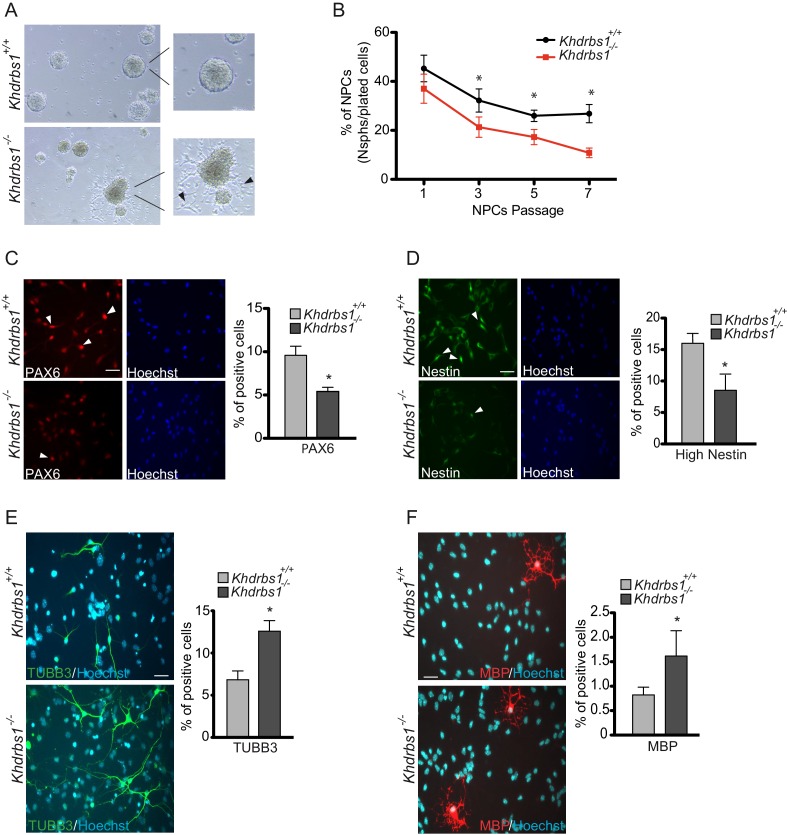
Sam68-/-NPCs lose stemness and are prone to differentiate in culture.(A) Bright field images of Khdrbs1+/+ and Khdrbs1-/- NPCs cultured in proliferating condition for 3 days in culture. The insets show higher magnification of a selected neurosphere. Black arrowheads point to Khdrbs1-/- NPCs exiting the sphere and attaching to the surface. (B) Clonogenic assay of Khdrbs1+/+ and Khdrbs1-/- NPCs. Clonogenicity was expressed as the percentage of neurospheres obtained from the seeded NPCs at each indicated passage. Data represent mean±SD of 3 independent experiments; * p<0.05. (C and D) Immunofluorescence analysis of the stemness markers PAX6 (C) and Nestin (D) in Khdrbs1+/+ andKhdrbs1-/- NPCs cultured in differentiating condition for 1 day. Arrowheads point to high-PAX6+ cells (C) and high-Nestin+ cells (D). Bar graphs represent (mean±SD) measurement of number of high-PAX6+ cells (C) and high-Nestin+ cells (D). N = 3; * p<0.05; scale bars 50 µm. (E and F) Immunofluorescence analysis of expression of the neuronal marker TUBB3 (E) and of the oligodendrocyte marker MBP (F) in Khdrbs1+/+ and Khdrbs1-/- NPCs, differentiated for 3 days. Bar graphs represent (mean±SD) measurement of number of TUBB3+ cells (E) and MBP+ cells (F). Analysis results were reported on the graphs on the right of the images. N = 3; * p<0.05; scale bars 50 µm. NPCs, Neural progenitor cells.DOI:
http://dx.doi.org/10.7554/eLife.20750.00810.7554/eLife.20750.009Figure 4—source data 1.List of the genes upregulated and downregulated inSam68 knockout NPCs.Yellow=upregulated genes; green=downregulated genes. NPCs, Neural progenitor cells.DOI:
http://dx.doi.org/10.7554/eLife.20750.00910.7554/eLife.20750.010Figure 4—source data 2.List of exons regulated by SAM68 in mouse NPCs.Green: genes downregulated at expression level; Yellow: genes up-regulated at expression level; White: genes unchanged at expression level. NPCs, Neural progenitor cells.